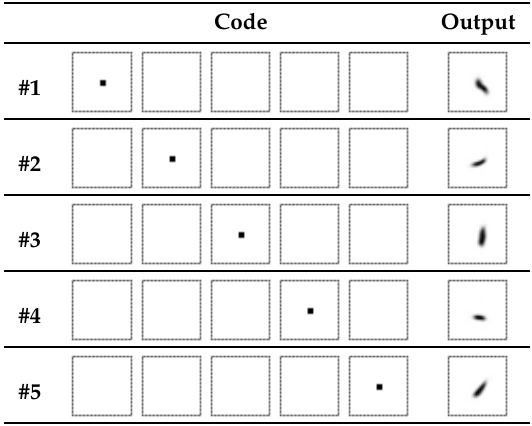
Table 12. AF5 decoder results for synthetic encoding, where only one point is activated.